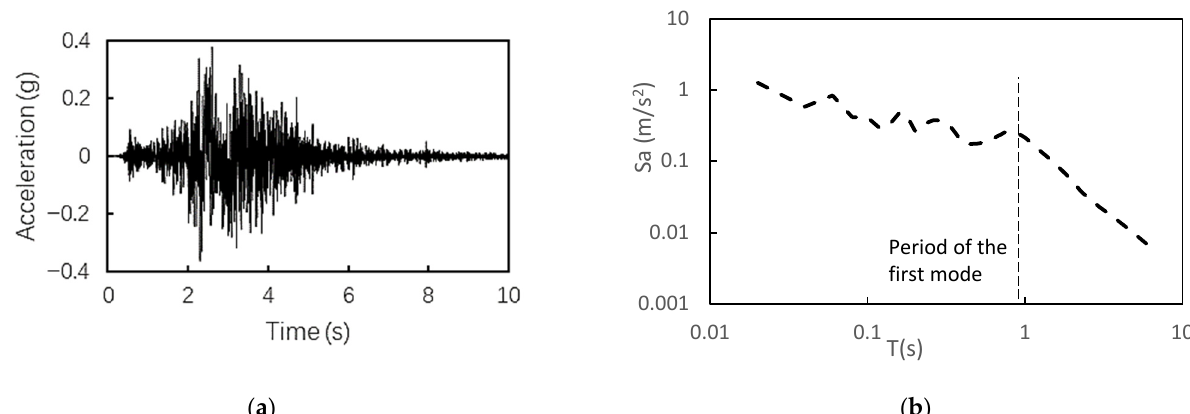
Figure 12. Earthquake input: ( a ) time history; ( b ) response spectrum.